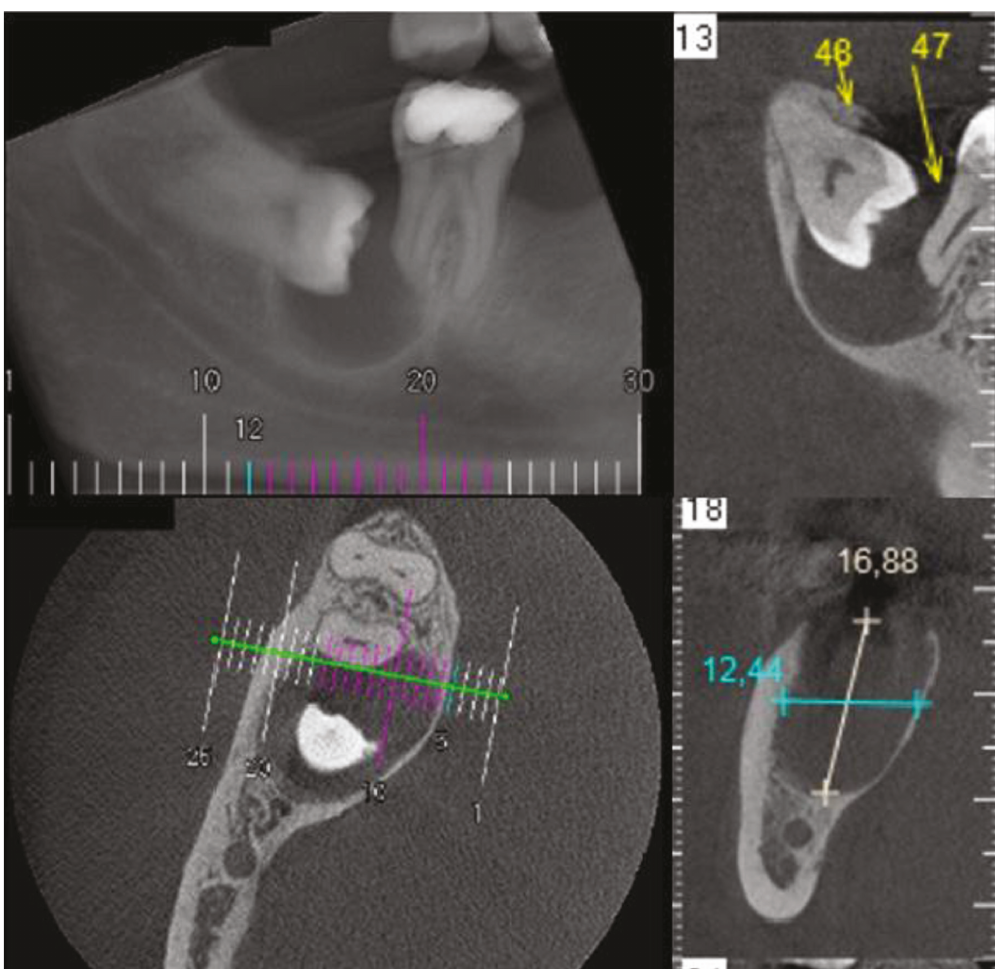
Figure 1: Preoperative CBCT showing well-de fi ned unilocular radiolucency associated with an impacted right third molar extending to the distal root of the second